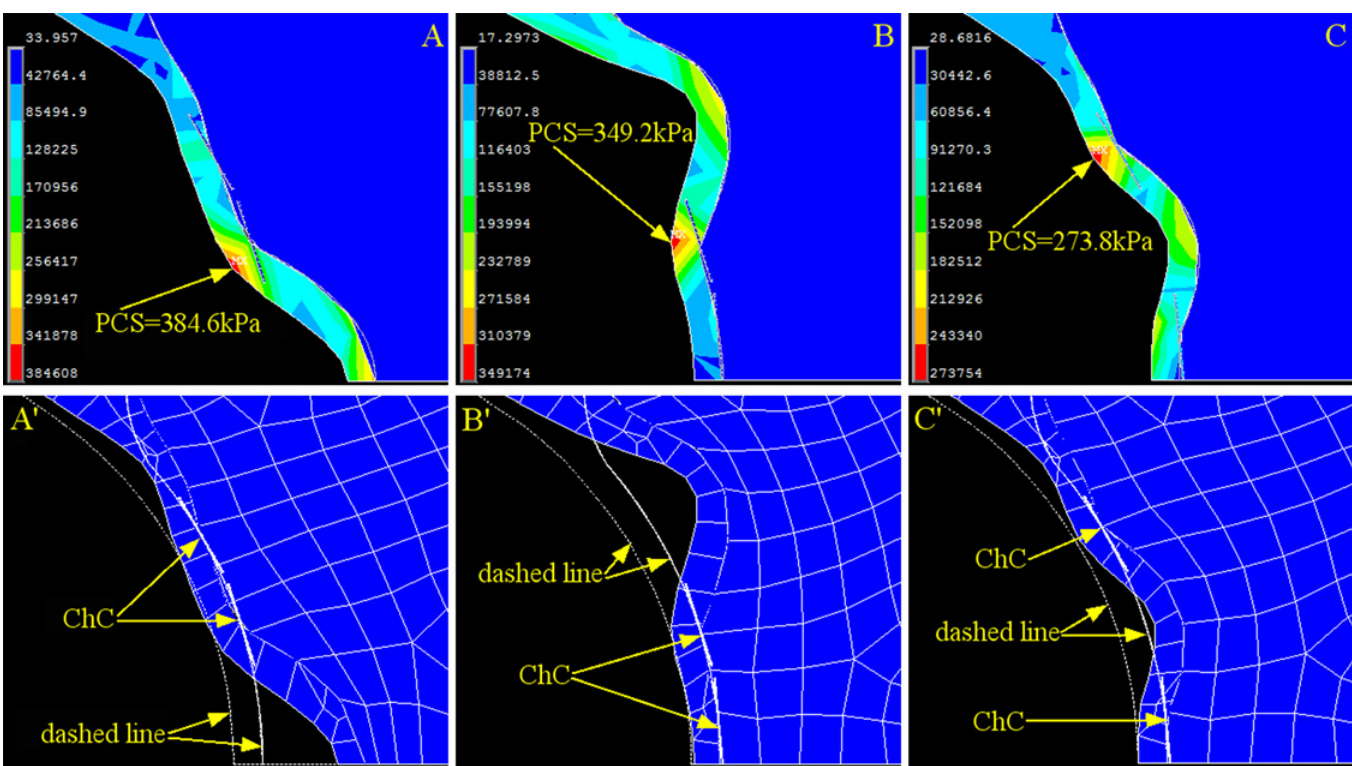
Fig 8. Stress and Strain of the Cap with Two Cholesterol Crystals at any Two Random Positions. (A) Contour plot of the stress on the fibrous cap when cholesterol crystals are located at the shoulder and halfway between the shoulder and the cap center. (A ’ ) Corresponding strain contour of the cap of A. (B) Contour plot of the stress on the fibrous cap when cholesterol crystals are located halfway between the shoulder and the cap center and at the cap center. (B ’ ) Corresponding strain contour of the fibrous cap of B. (C) Contour plot of the stress on the fibrous cap when cholesterol crystals are located at the shoulder and at the cap center. (C ’ ) Corresponding strain contour of the fibrous cap of C. The dashed line is the original contour before loading, and the meshed section is the deformed cap after loading. PCS: peak circumferential stress. ChC: cholesterol